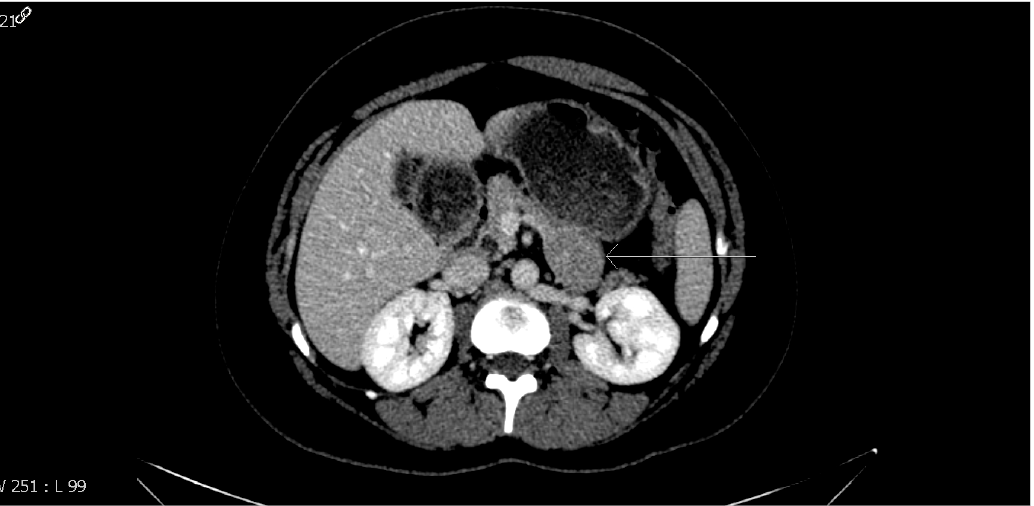
Figure 1. CT scan image of the abdomen showing an oval-shaped homogenous mass arising from the pancreatic tail inferiorly (arrow), measuring approximately 4 cm in diameter. Laparoscopic cor- poreo-caudal pancreatectomy and splenectomy were performed for complete resection of the mass. No metastatic deposits or nodal enlargements were noted during